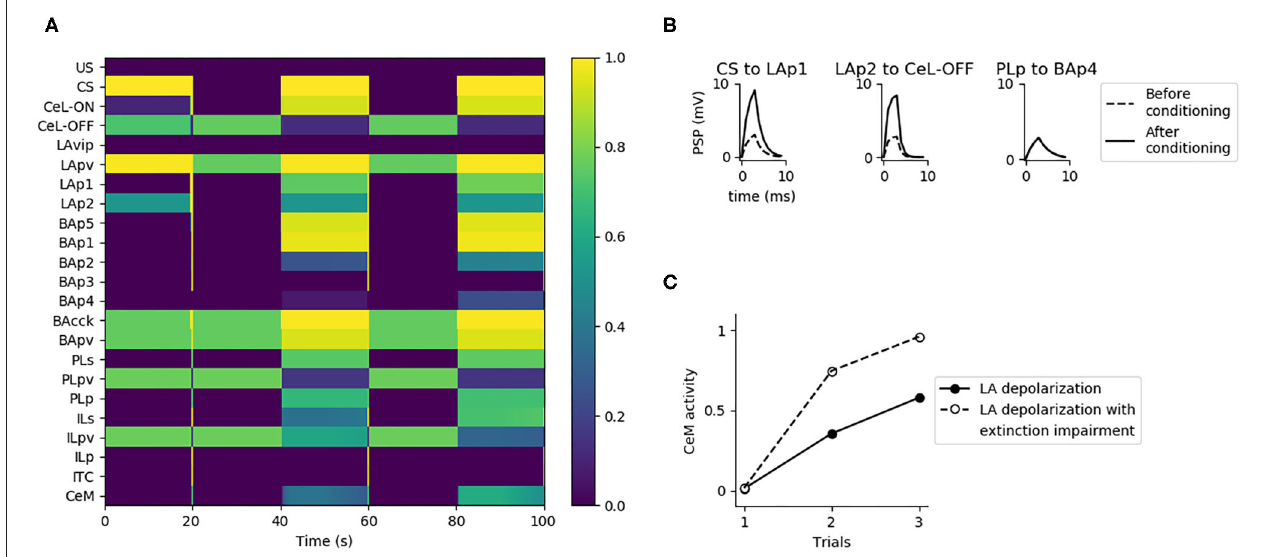
FIGURE 9 | Substitution of US with LA activation during conditioning. (A) When LAp1 and LAp2 are activated at they maximum, substituting the US during the three trials of conditioning, the extinction circuit composed by BAp2, ILp, BAp3, and ITC is engaged. This causes the suppression of the activity of BAp4. (B) When LA activation is used instead of the US there is potentiation of only two of the three connections that should undergo LTP during conditioning. (C) Fear conditioning obtained with LA activation, in control condition (Ctrl, black dots) or when the extinction pathway is inactivated (BAp2 inactivation, white dots).